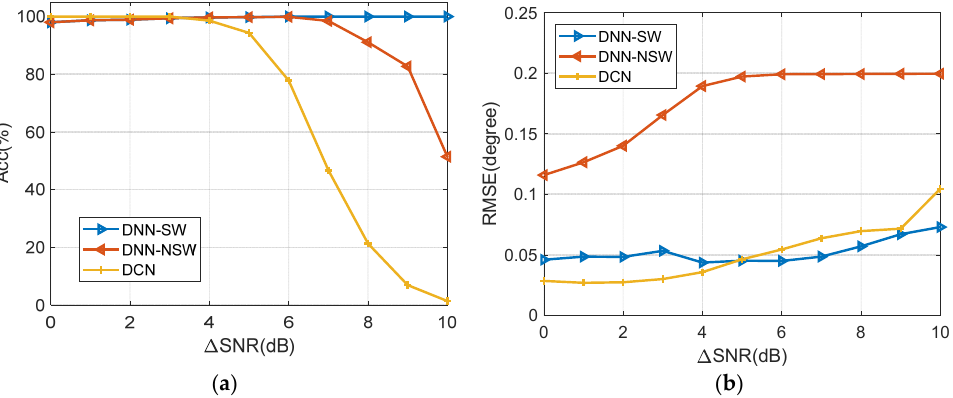
Figure 8. The DOA estimation performance of two unequally-powered sources from the directions of 6.28° and 15.72°. ( a ) Acc, ( b ) RMSE.